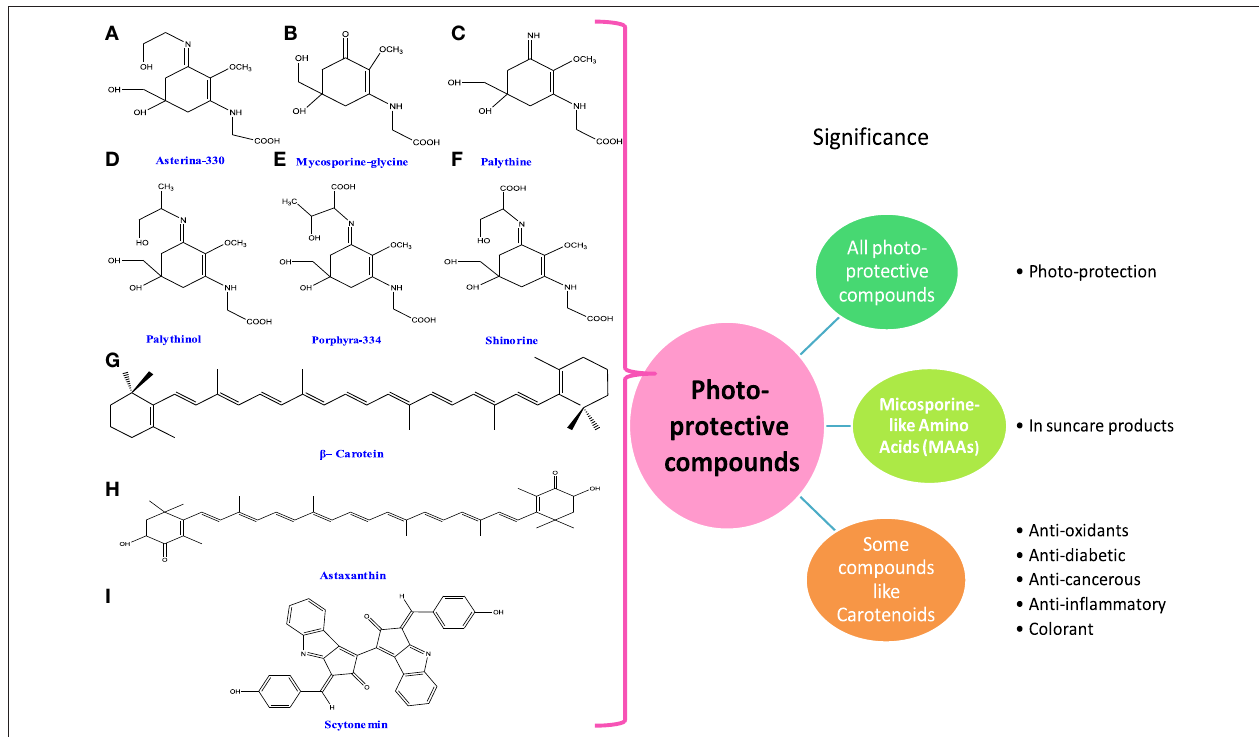
FIGURE 4 | Chemical structures and significance of photoprotective compounds: (A) asterina-330, (B) mycosporine-glycine, (C) palythine, (D) palythinol, (E) porphyra-334, (F) shinorine, (G) β -carotene, (H) astaxanthin, and (I) scytonemin obtained from different cyanobacteria and